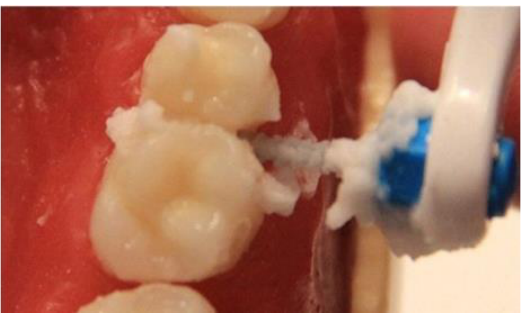
Figure 6. Interdental brush in action.